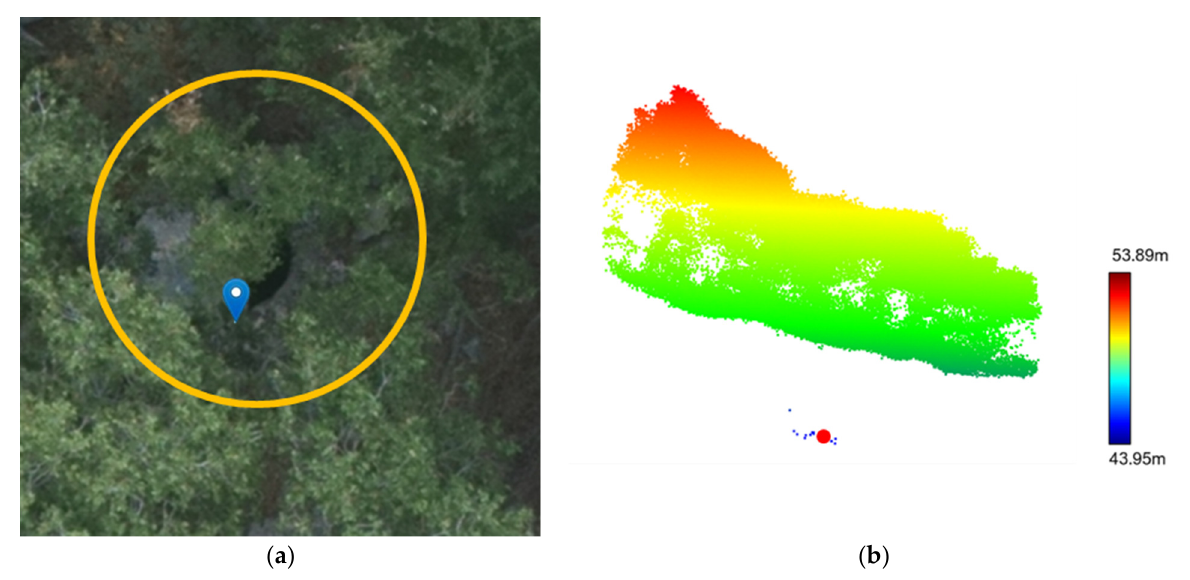
Figure 1. Illustration of a cistern in ( a ) an image and ( b ) LiDAR data (side view)—the cistern is hardly visible in the image, while it is clear in the point cloud (the blue placemark and red dot show the same location).